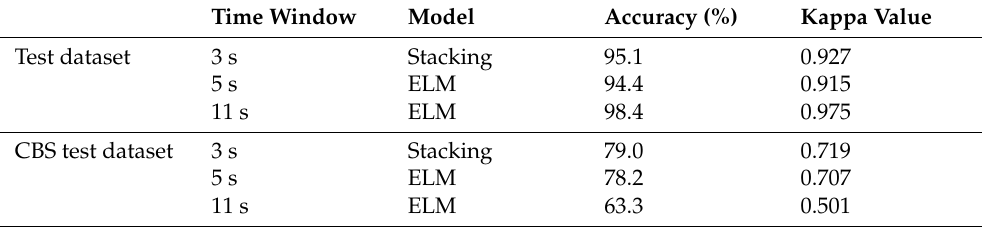
Table 8. Summary of accuracy and the Kappa values for three ML models (with the highest classifica- tion accuracy at the 3, 5 and 11 s time windows on the CBS test dataset, trained by 12 features from three-axis accelerometer and three-axis gyroscope data) at the 3, 5 and 11 s time windows on the test dataset and the CBS test dataset